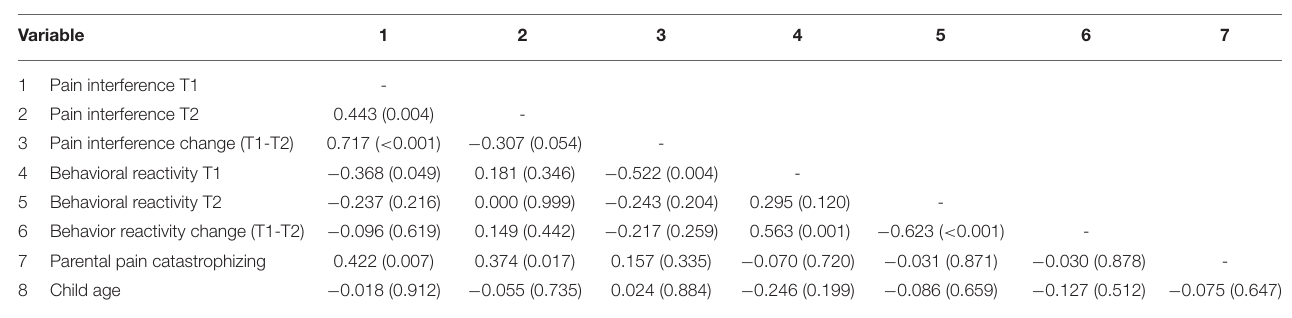
TABLE 3 | Bivariate relationships among all predictors and outcomes.